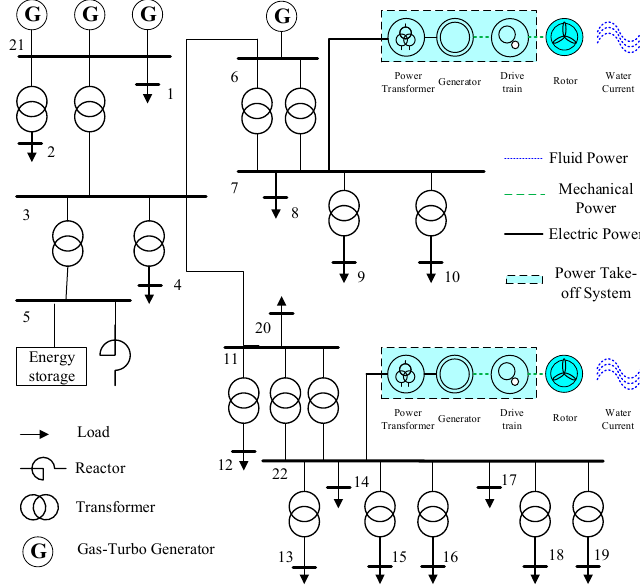
ff shore microgrid in island operation Figure 3. Offshore microgrid in island operation mode. Figure 3. O